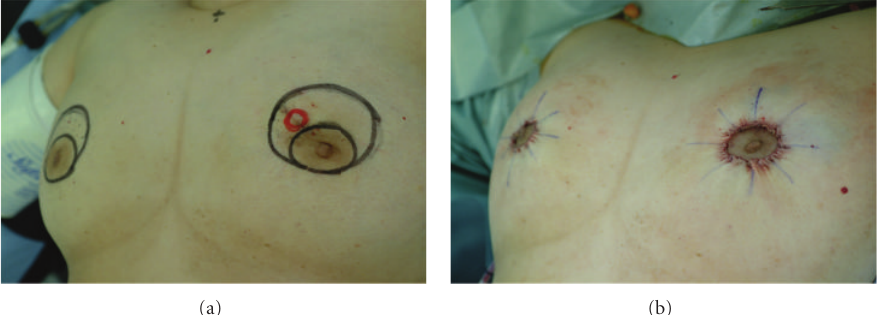
Figure 3: Pre- and postoperative images of case 1. (a) A crescent of skin and the parenchymal tissue just under it were removed. (b) Identical bilateral procedures were performed.